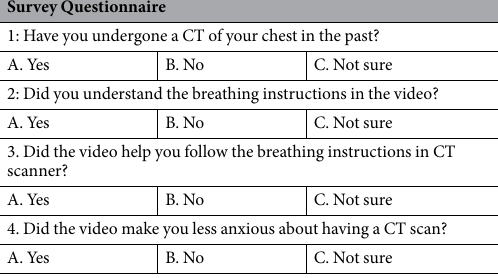
Table 2. Survey questionnaire used in our study for the PDSA-2